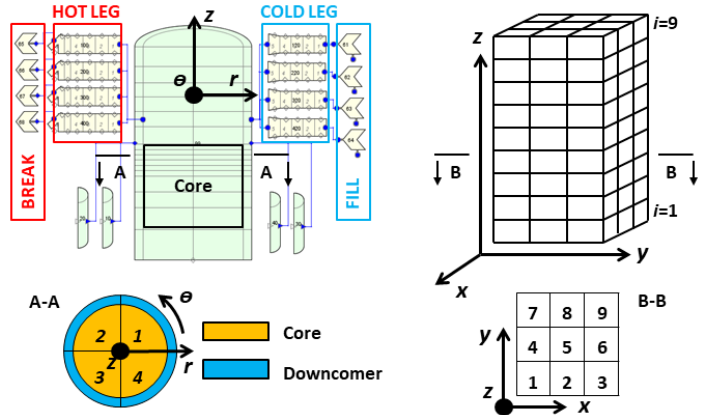
Figure 10. Nodalization of the CY-V ( left ) and the CA-V ( right ). Four FILL and BREAK components are connected to a portion of the cold and hot legs to define the boundary conditions of the problem, e.g., loops mass flow rate, coolant temperature, and pressure. The coolant enters the cold legs, then flows into the down- comer of the RPV and from there to the lower plenum where the flow changes direction and flows upwards entering into the core bottom. The coolant flows through the core and enters the upper plenum. Finally, it exits the RPV and flows into the BREAKs through the hot legs. The core is modeled by the Cartesian VESSEL, which is connected to the RPV- axial face Nr. 2 (core inlet) and the axial face Nr. 11 (core outlet). Hence, the core region in